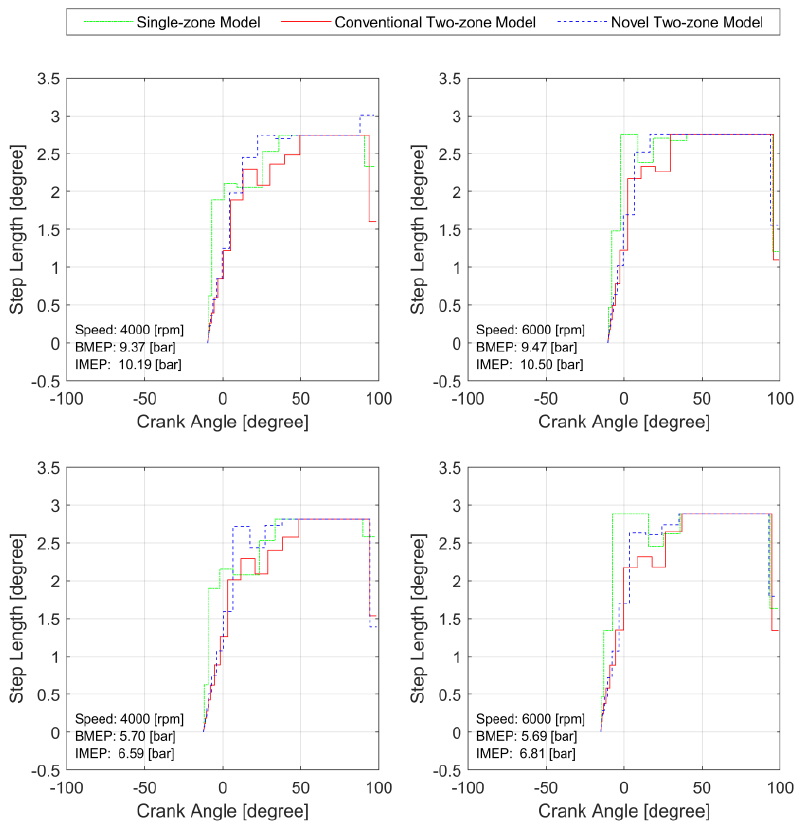
Figure 10. Simulation step length.